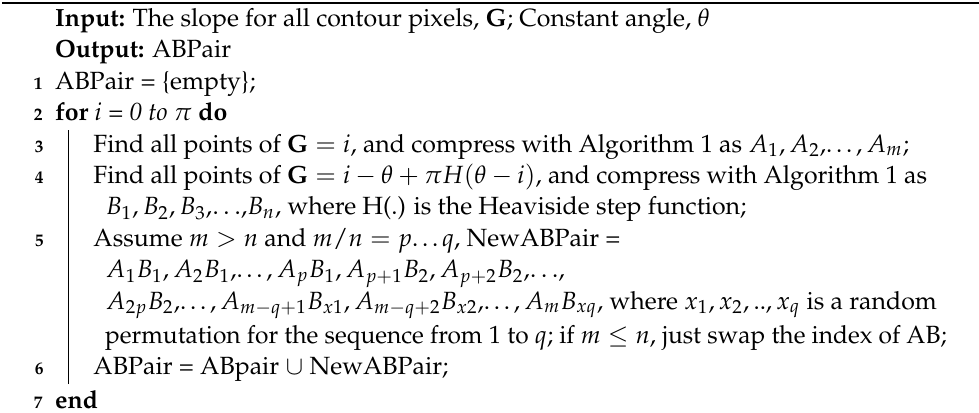
Algorithm 2: Find the AB pair from the edge